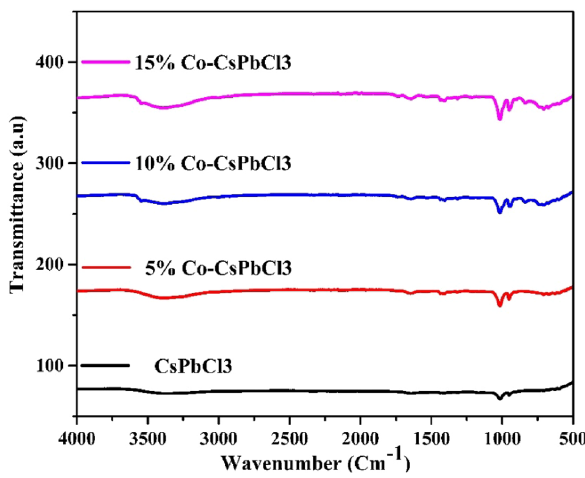
Figure 3. FTIR spectra of Pristine and Co:CsPbCl 3 nanostructures.